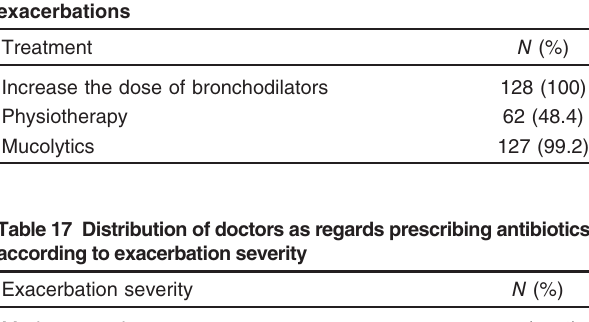
Table 18 Distribution of doctors according to type of commonly prescribed antibiotics in chronic obstructive pulmonary disease